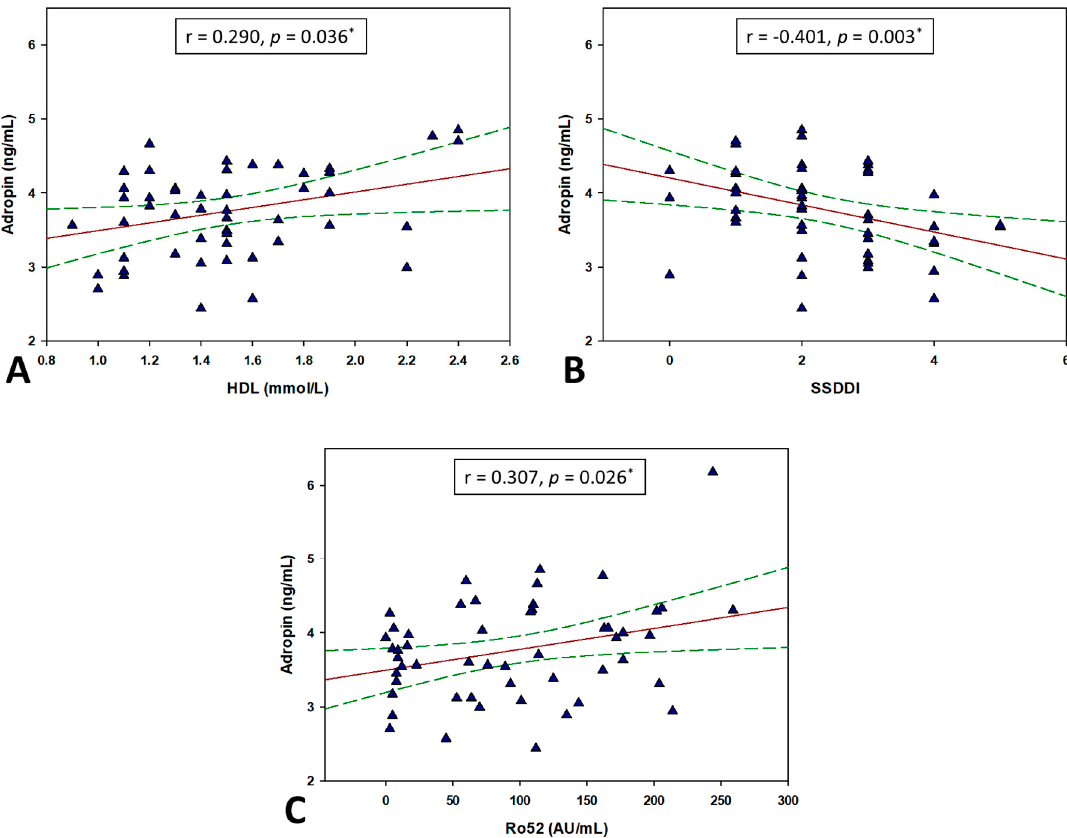
Figure 2. Correlation analysis of adropin levels with HDL ( A ), SSDDI ( B ) and antiSSA/Ro52 ( C ) in total study population (N = 104). * Pearson’s correlation coefficient. Red lines represent Pearson correlation coefficient and green lines represent respective 95% confidence intervals.